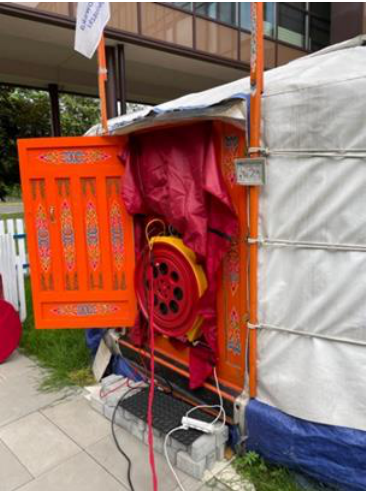
Figure 11. Blower-door fan installed in the external door of